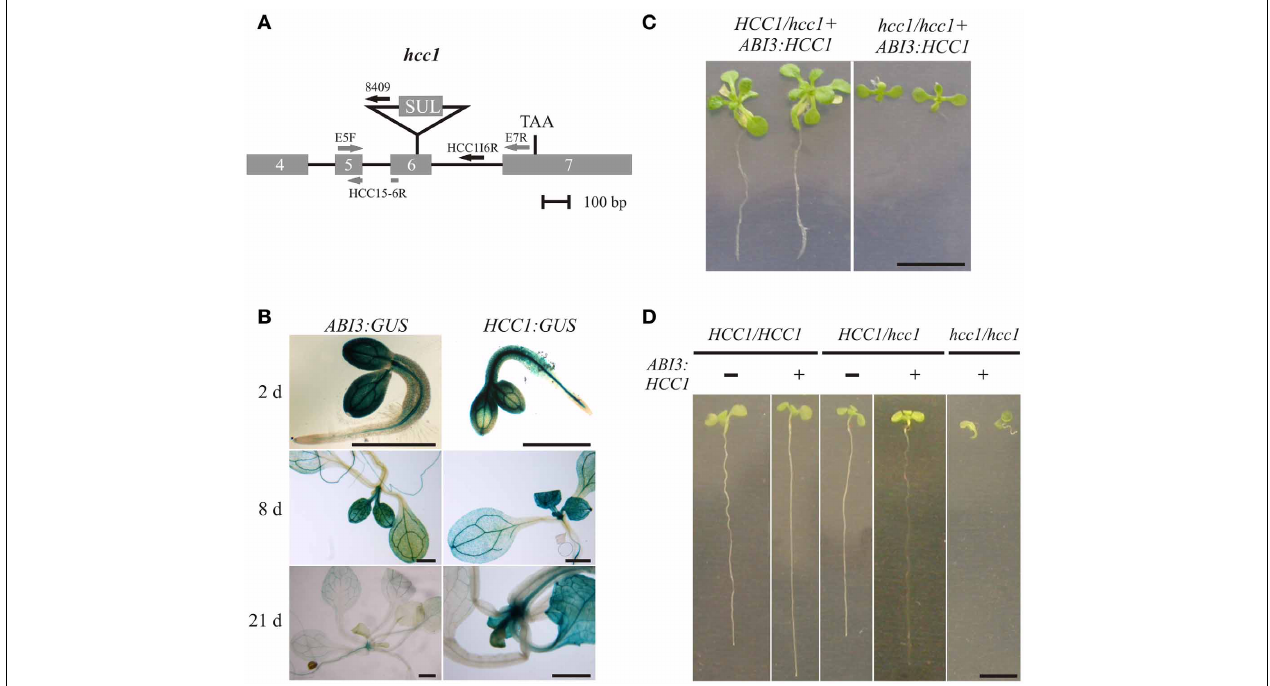
FIGURE 2 | Embryo-specific complementation of the hcc1 knockout. (A) A schematic diagram of the hcc1 allele is shown. The exons 4–7 and introns 4–6 of HCC1 are denoted by gray boxes and solid lines, respectively. The labeled arrows represent the primers used for genotyping. The gray and black arrow colors denote a binding site in a coding and noncoding region, respectively. Primer HCC1E5-6R spans the exon5-exon6 boundary. SUL, sulfadiazine resistance cassette; TAA, stop codon. (B) Seedlings selected on hyg from two ABI3:GUS lines (3 and 6) and the HCC1:GUS line 1 were stained for GUS activity at the indicated days after germination. The staining pattern was similar in both ABI3:GUS lines and representative images of line 3 are shown. The scale bars equal 1mm each. (C) Progeny from a selfing cross of the hemizygous hcc1 mutant complemented with ABI3:HCC1 (line